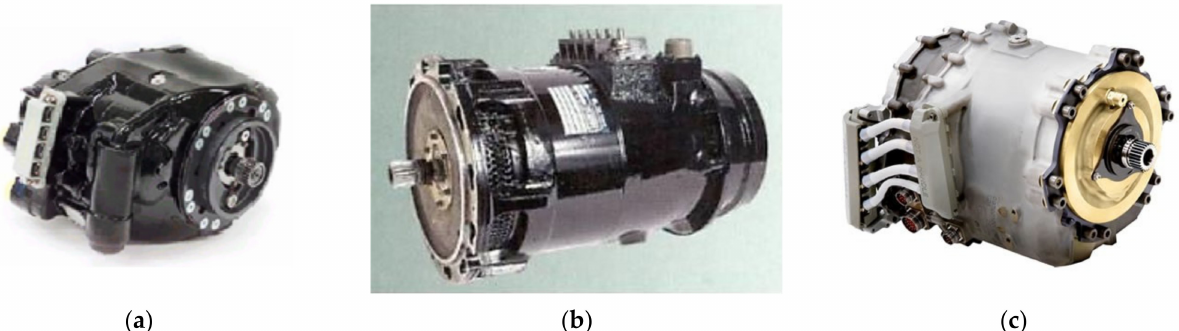
Figure 8. Evolution of main AC generators for commercial aircraft (images from Hamilton Sundstrand flyers): ( a ) Airbus A330 115 kVA IDG; ( b ) Airbus A380 150 kVA VFG; ( c ) Boeing B-787 250 KVA